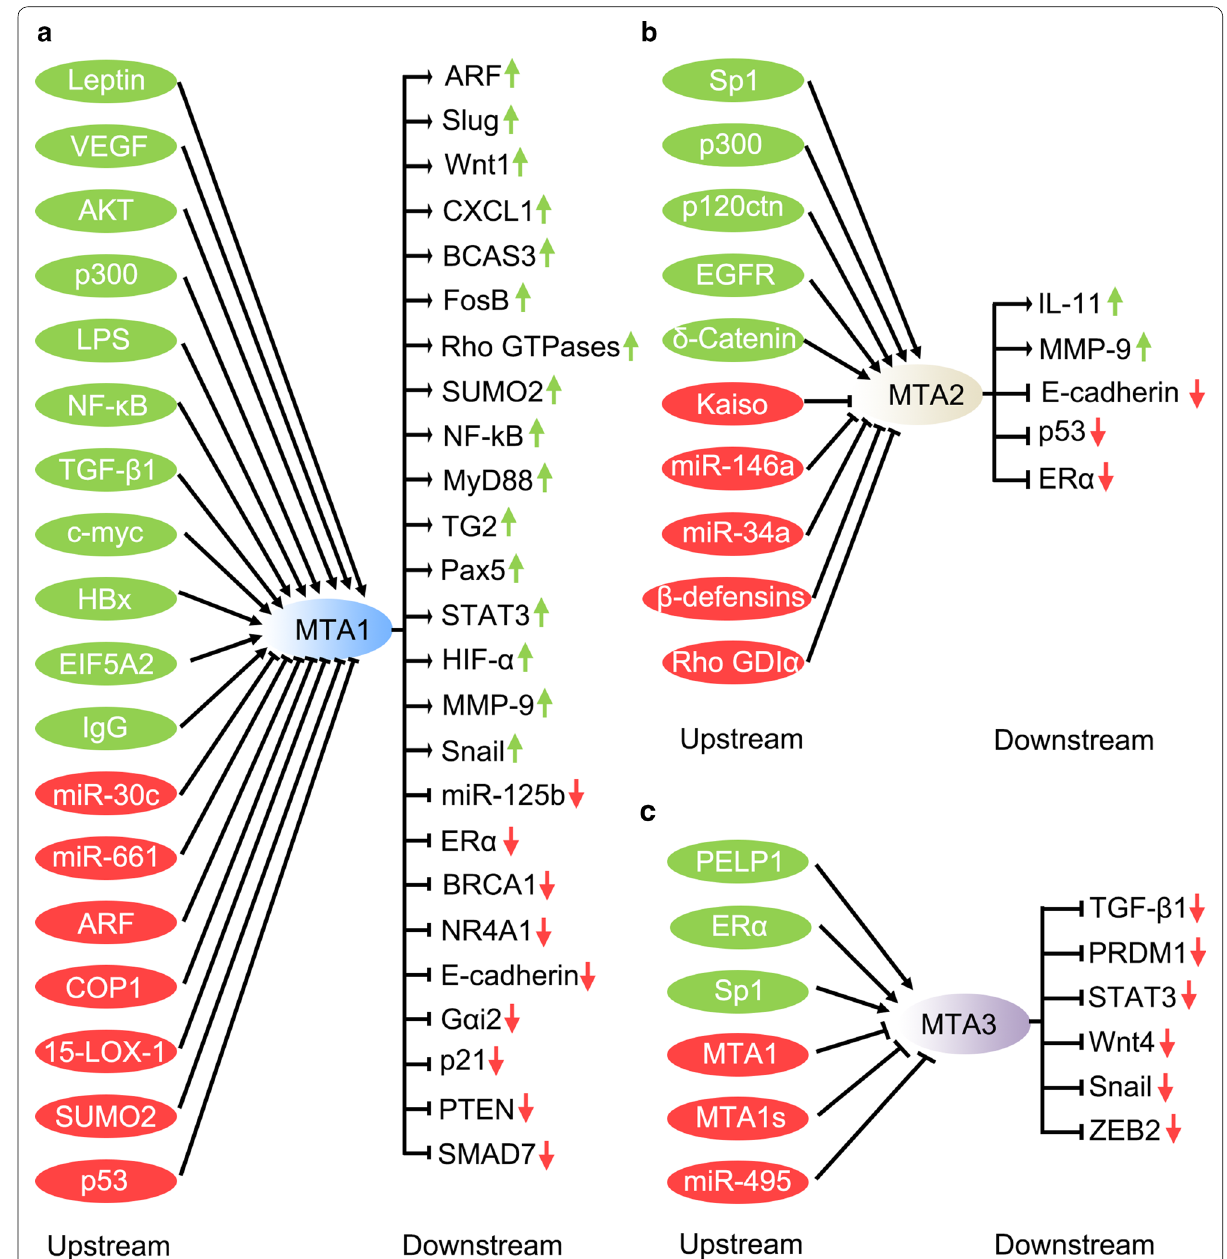
Fig. 2 Upstream regulators and downstream effectors of metastasis-associated proteins (MTAs) in human cancers. Upstream regulators that directly or indirectly up-regulate or down-regulate MTA1 ( a ), MTA2 ( b ), and MTA3 ( c ) are listed on the left side , whereas downstream effectors that are directly or indirectly regulated by MTAs are listed on the corresponding right side . VEGF vascular endothelial growth factor, AKT protein kinase, LPS lipopolysaccharide, NF - κB nuclear factor kappa-light-chain-enhancer of activated B cells, TGF - β1 transforming growth factor beta 1, HBx hepatitis B viral protein, EIF5A2 eukaryotic translation initiation factor 5A-2, ARF alternative reading frame, COP1 coat protein 1, 15 - LOX - 1 15-lipoxygenase-1, SUMO2 small ubiquitin-related modifier 2, CXCL1 chemokine (C-X-C motif) ligand 1, BCAS3 breast carcinoma-amplified sequence 3, TG2 transglu- taminase 2, Pax - 5 paired box protein 5, STAT3 signal transducer and activator of transcription 3, HIF - α hypoxia-inducible factor-α, MMP - 9 matrix metallopeptidase 9, miR - 125b microRNA-125b, ERα estrogen receptor alpha, BRCA1 breast cancer 1, NR4A1 nuclear receptor subfamily 4 group A member 1, Gαi2 Gi alpha subunit 2, PTEN phosphatase and tensin homolog, SMAD7 mothers against decapentaplegic homolog 7, Sp1 specificity protein 1, p120ctn p120 catenin, EGFR epidermal growth factor receptor, GDIα GDP dissociation inhibitor alpha, hBD - 3 human β-defensin 3, IL - 11 interleukin-11, PELP1 proline, glutamic acid, leucine-rich protein 1, MTA1 s metastasis-associated protein 1s, PRMD1 PR domain containing 1, with ZNF domain, ZEB2 zinc finger E-box-binding homeobox